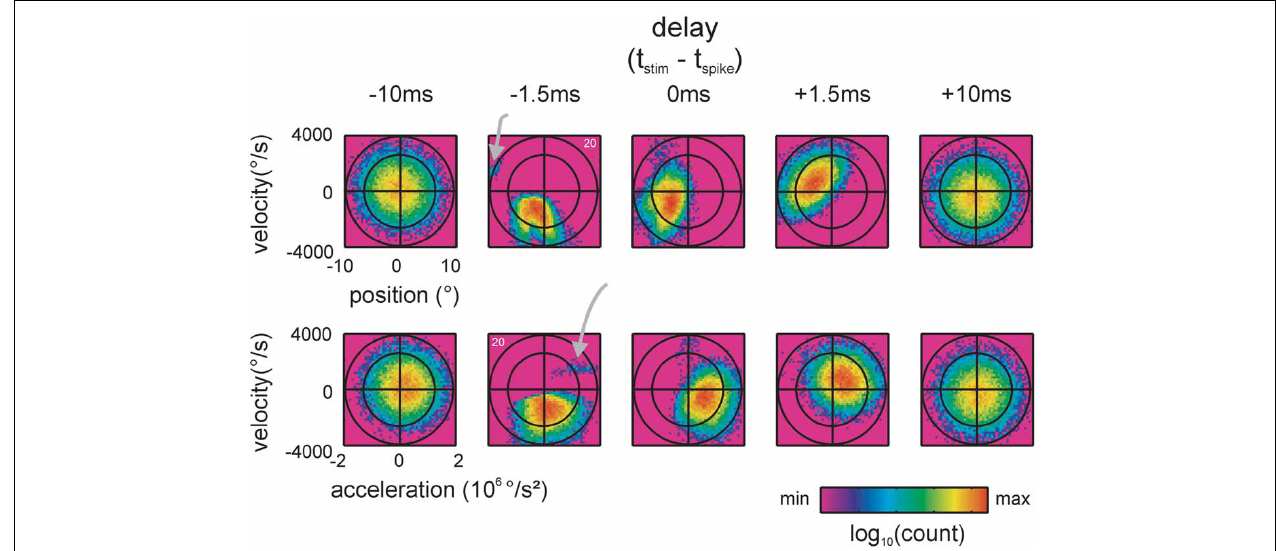
FIGURE 3 | Spike-triggered kinematic features. Two dimensional projections, taken from the 3D distributions of stimulus space spanned by position, velocity and acceleration, are shown. Top: position and velocity. Bottom: acceleration and velocity. The two ellipses (black lines, scales are chosen such that they appear as circles) indicate the total stimulus space (2 times and 3 times standard deviation of the 2D Gaussian). 2D histograms of